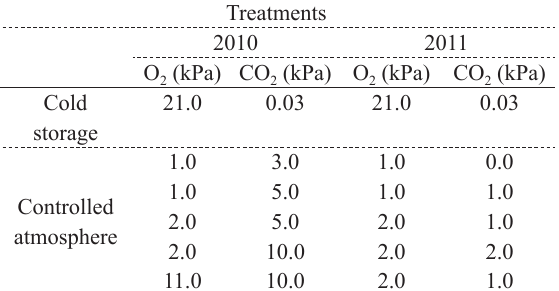
Storage conditions (O in both experiments (2010 and